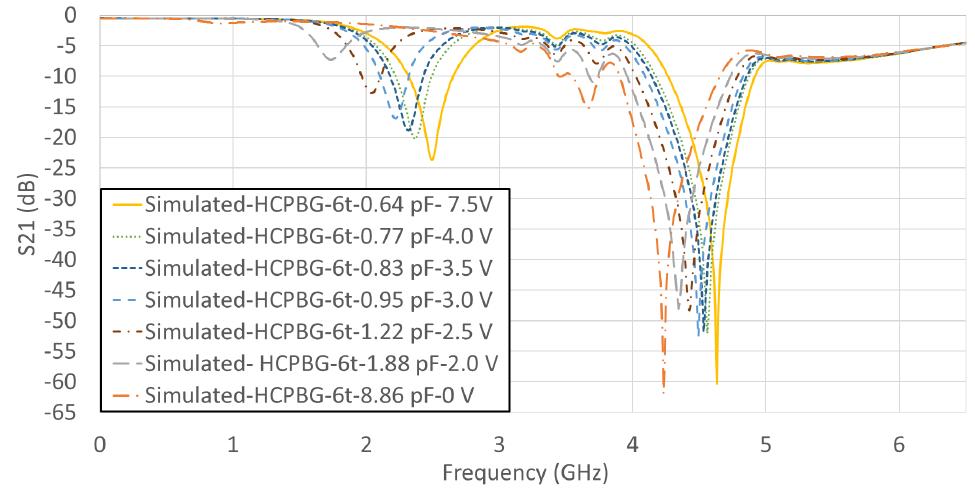
Figure 15. Simulated—transmission loss for voltage values: 7.5, 4.0, 3.5, 3.0, 2.5, 2.0, 0.0 Volts.